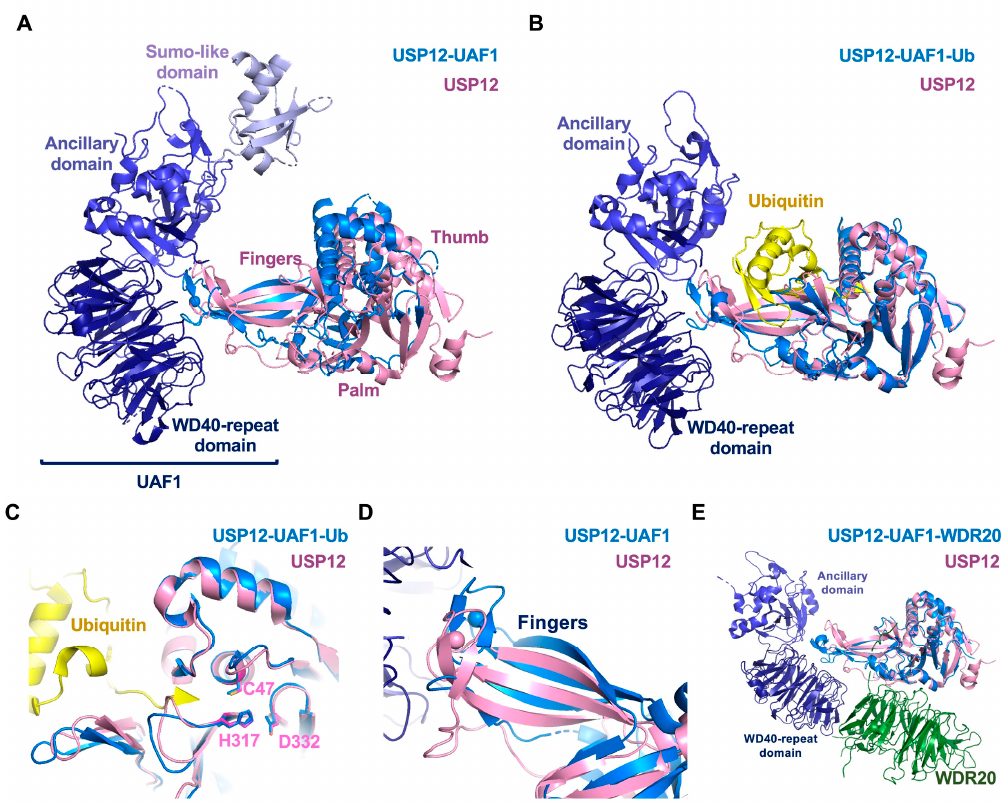
Figure 7. Structure of USP12-UAF1-WDR20. ( A ) Structure of with USP12-UAF1. ( B ) Structure of with USP12-UAF1(9-580)-Ub. ( C ) Active site of USP12. ( D ) Differences of Fingers domain in the absence and presence of UAF1. ( E ) Structure of USP12-UAF1(9-580)-WDR20. Free USP12 (pink), UAF1(deep blue), WDR20 (green), ubiquitin (yellow). (PDB: 5K16, 518W, 5K1B, and 5K1C).